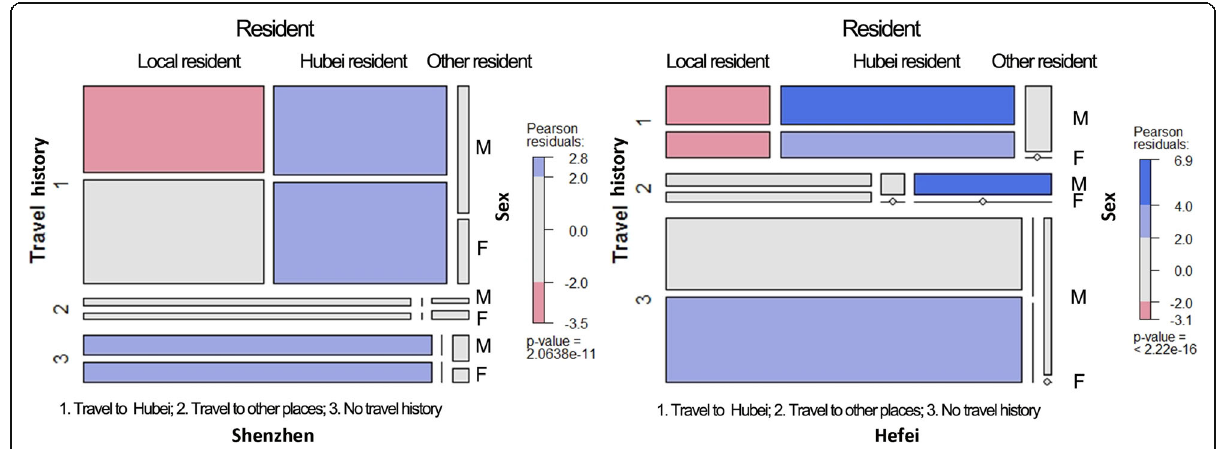
Fig. 4 Demographic structure of infected cases in Shenzhen and Hefei